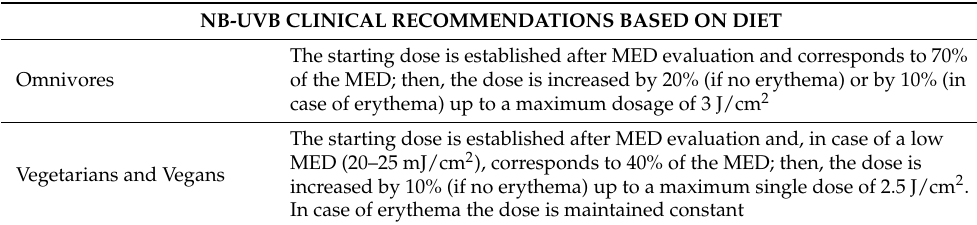
Table 4. Clinical recommendations based on diet for NB-UVB phototherapy in patients with psoriasis. NB-UVB CLINICAL RECOMMENDATIONS BASED ON DIET